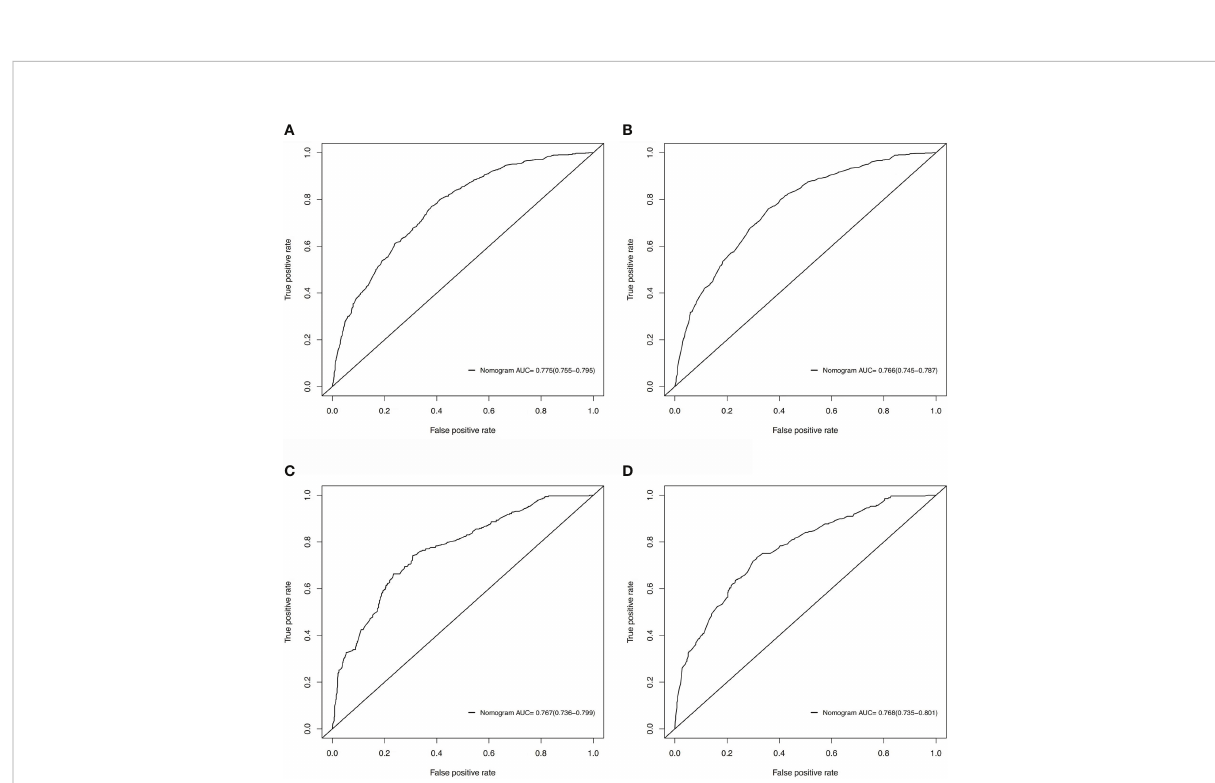
FIGURE 4 ROC curves for discrimination of the nomograms in predicting all-cause and cancer-speci fi c early death in the training cohort (A, B) and the validation cohort (C, D)